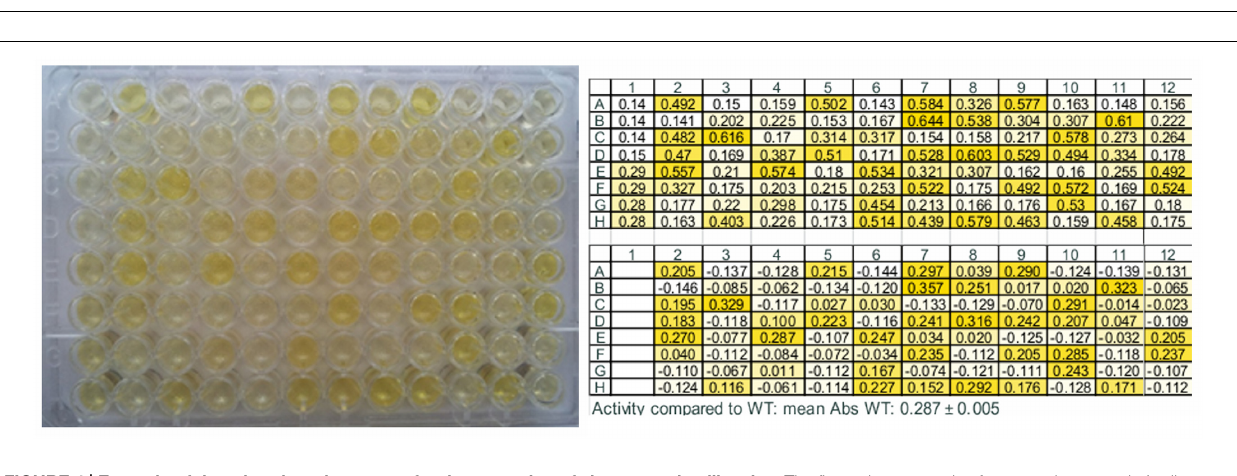
FIGURE 4 | Example of the microtiter plate assay for the screening of site-saturation libraries. The first column contains four negative controls (wells 1A–1D), lysate of E. coli BL21 (DE3) Gold carrying pET26b( + ) vector without insert, and four positive controls (wells 1E–1H), lysate of E. coli BL21 (DE3) Gold expressing the wild type enzyme. (Left) The picture shows the plate 35 min after addition of the detection solution. (Right: Top ) Absorbance values of the same plate measured in a plate reader at 442 nm. (Right: Bottom) Absorbance difference between WT and variants. The screening was performed with α -methylstyrene in presence of tert -butyl hydroperoxide as substrates and vanillin for detection using the standard assay conditions described in Section “Materials and